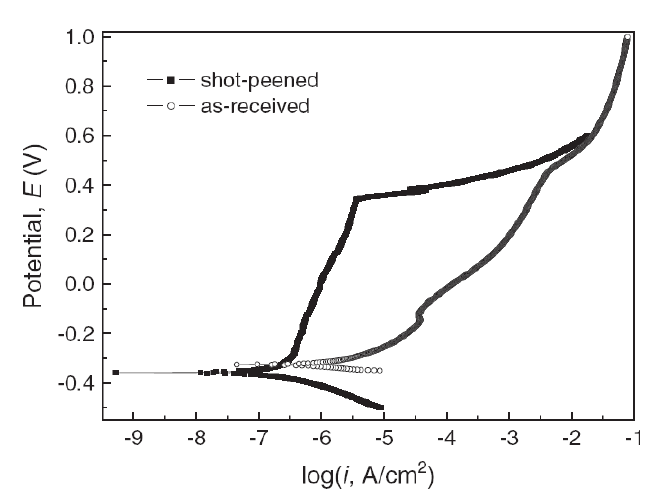
Figure 9: Potentiodynamic polarization curves of shot-peened and as-received samples of 1Cr18Ni9Ti stainless steel obtained in 3.5% NaCl solution